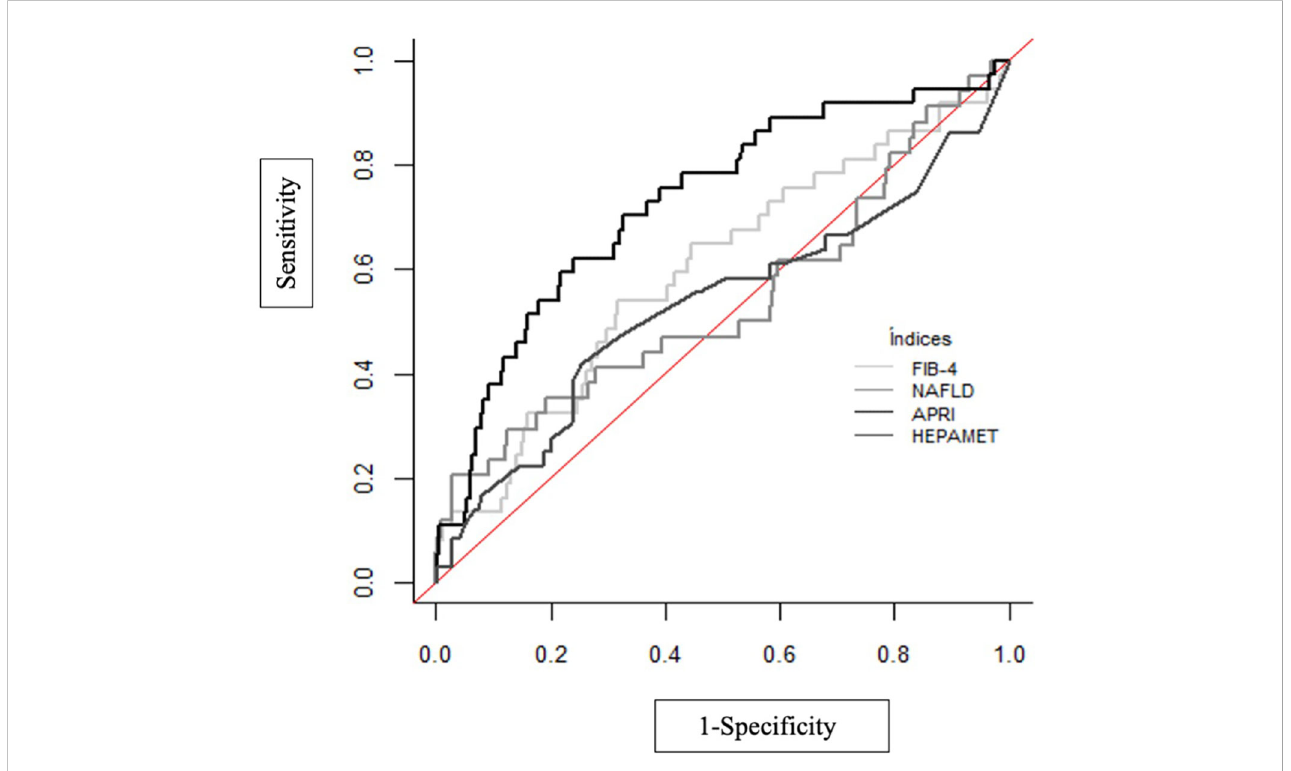
FIGURE 1 ROC curves for non-invasive fi brosis scores to